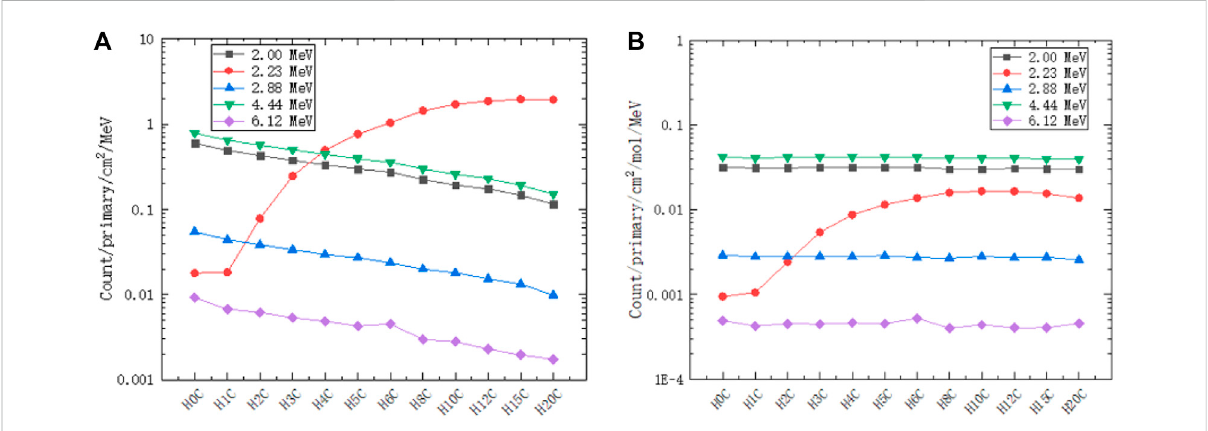
FIGURE 12 Counts of selected gamma lines from PGS in different hydrogen and carbon combinations: 2.00 MeV, 2.23 MeV, 2.88 MeV, 4.44 MeV, and 6.12 MeV. (A) The counts of 2.00 MeV, 2.88 MeV, 4.44 MeV, and 6.12 MeV have a linear relationship with the carbon concentration. (B) The molar count curves of these selected gamma lines are at the same level except for 2.23 MeV.